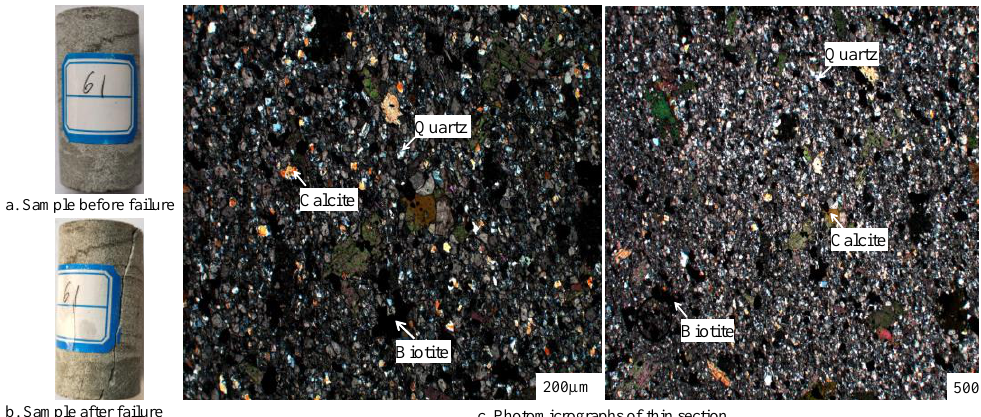
Figure 1. Typical clastic sandstone sample during the triaxial compression test.